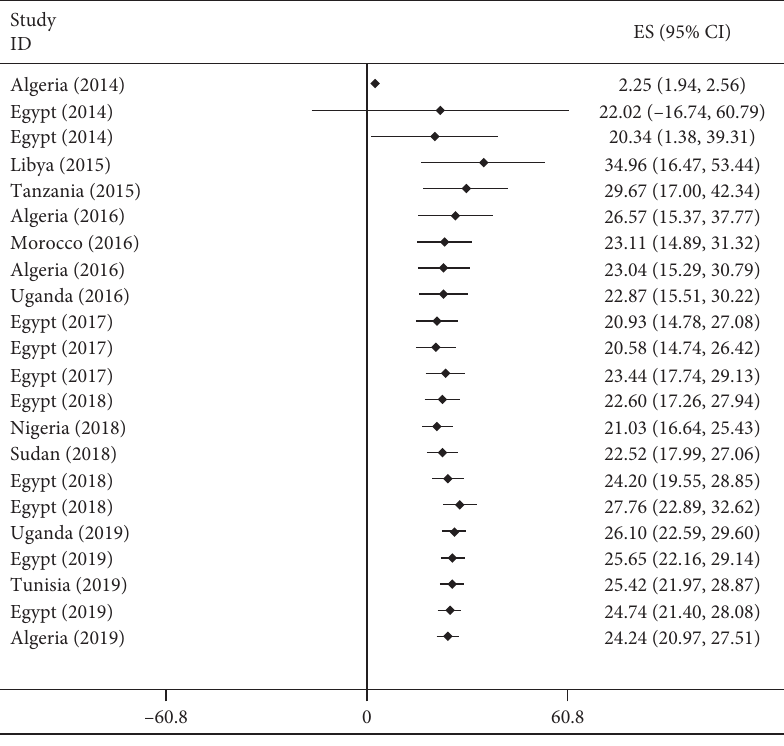
Figure 7: Cumulative meta-analysis of CPPA between 2014 and 2019 G.C. in Africa.